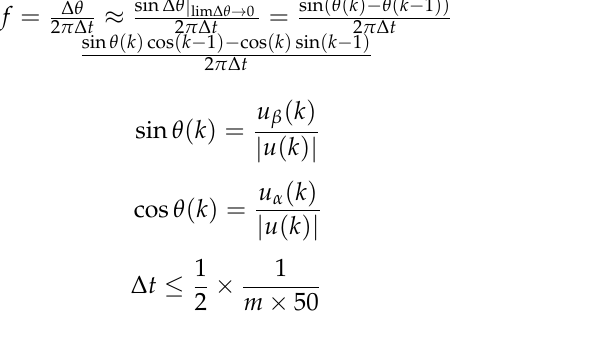
Figure 4. Rotation vector diagram of grid side voltage at adjacent sampling times.